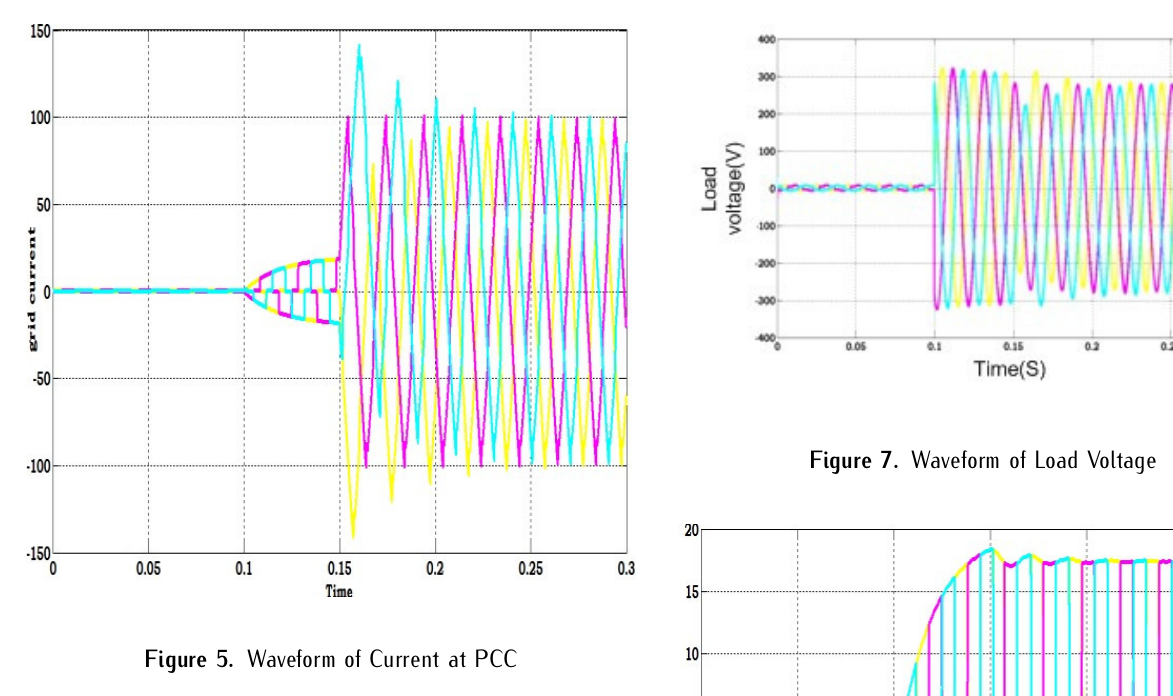
Figure 5. Waveform of Current at PCC